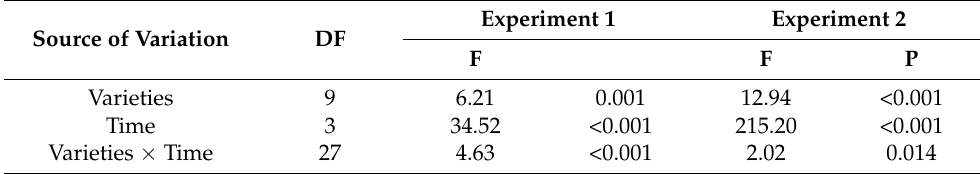
Table 7. Effect of variety, time and interaction on the incidence of bacterial wilt on cut plants of amaranth in the field.